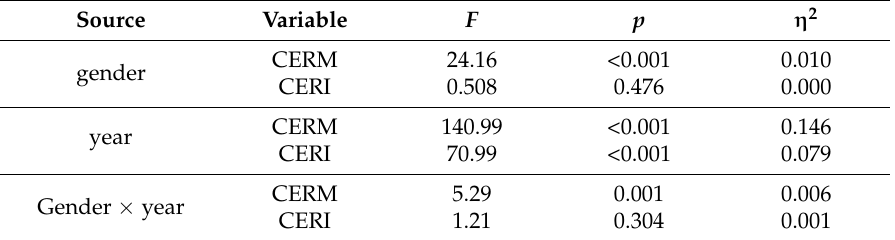
Table 7. Tests of between-subjects effects for the factors gender and year in CERM and CERI.